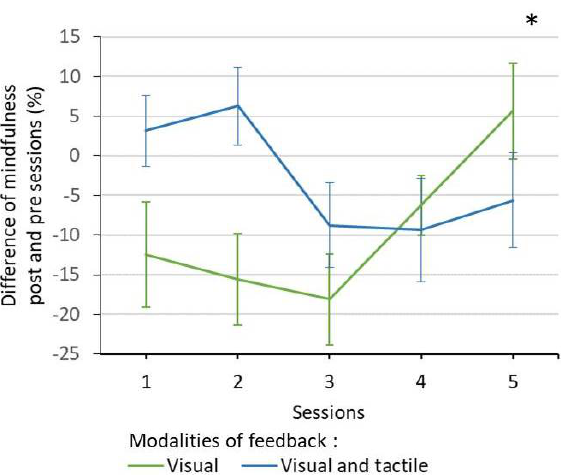
Figure 8. Evolution over the sessions of the mindfulness between the end and the beginning of session depending on the type of feedback. The single * on the top corner represents how significant the interaction “Modality*Session” represented in this Figure is, i.e., p ≤ 0.05. “Modality” also has a significant influence on the mindfulness between the end and the beginning of session, i.e., p ≤ 0.05. Regardless of the modality of feedback that they were training with, and apart from the fourth session, participants’ motivation increased more when they started training with a visual feedback than when they started training with a multimodal feedback. Overall, the difference of motivation between the end and the beginning of the session seems to increase over the sessions (see Figure